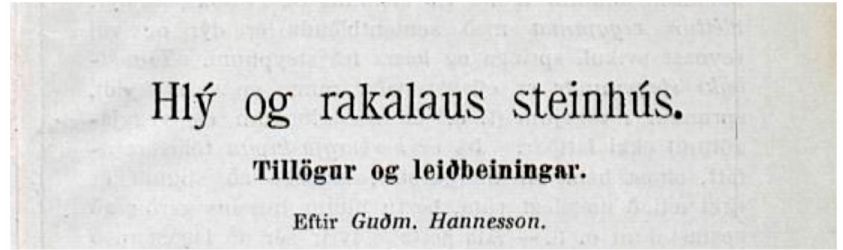
Figure 3. Guðmundur Hannesson, Hl ý og rakalaus steinh ú s, B ú naðarrit , Vol. 27, 1913. Full article publicly available at t í